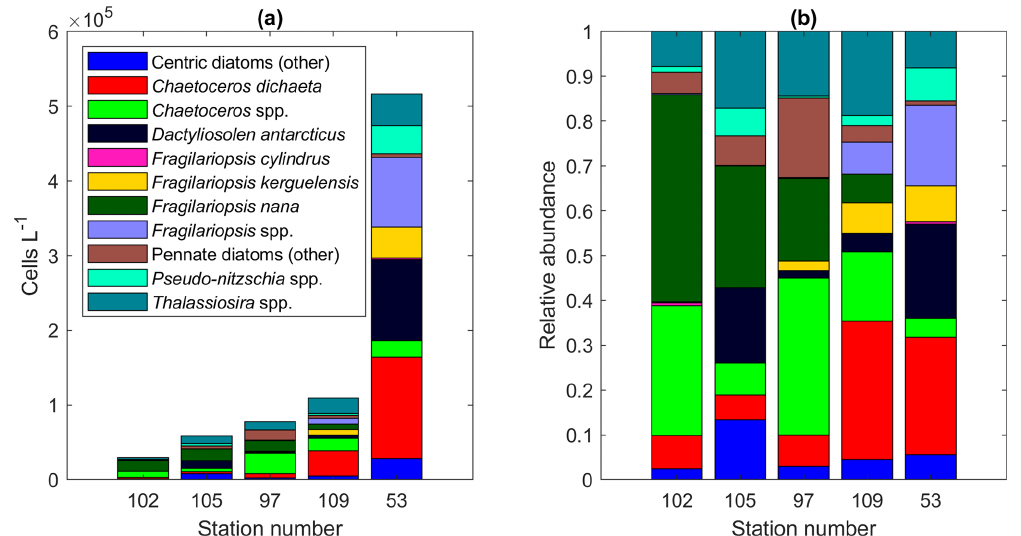
Figure A15. (a) Diatom abundance and (b) relative abundance in the south–north transect at 6 ◦ E, including station 53 just north of the transect (average abundances per